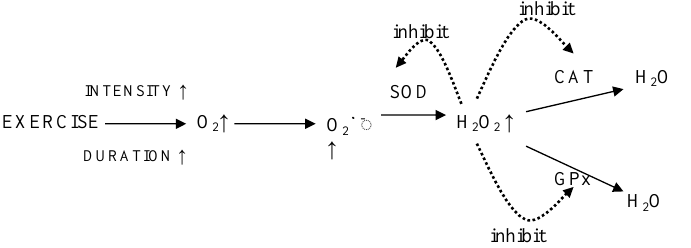
Figure 6. Relationship between intensity and duration of exercise with Reactive Oxygen Species (ROS)